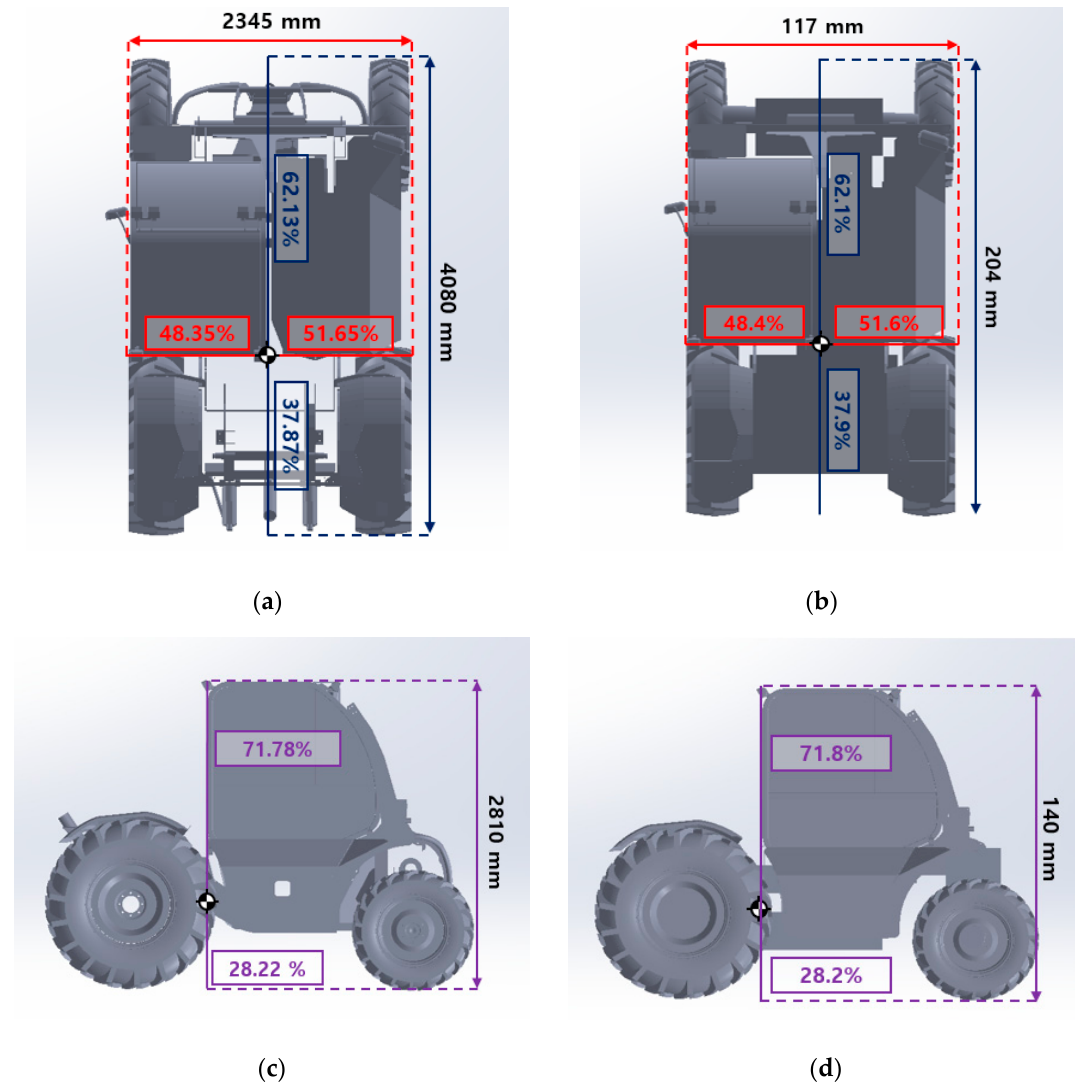
Figure 5. Overall dimension and relative position of the gravity center for the original and 1/20 scale- down miniature model: ( a ) Length and width ratio of the original model; ( b ) Length and width ratio of the miniature model; ( c ) Height ratio of the original model; ( d ) Height ratio of the miniature model.